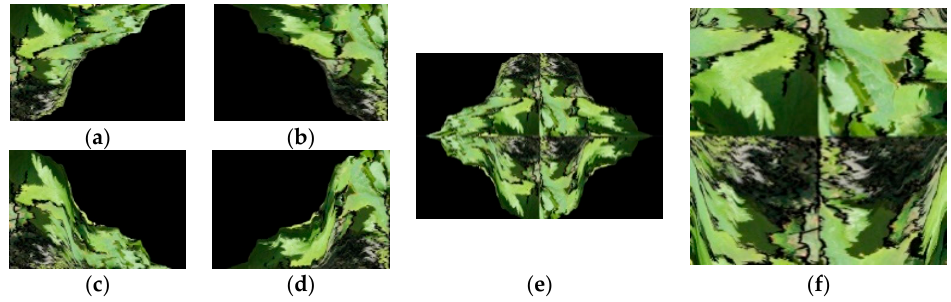
Figure 8. The steps of the proposed four-corners-in-one method: ( a ) Northwest corner; ( b ) northeast corner; ( c ) southwest corner; ( d ) southeast corner; ( e ) images ( a – d ) joined after a rotation of 180° of each image; ( f ) larger square image patch extracted from ( e ), with non-black pixels inside it (enlarged view for better visualization).